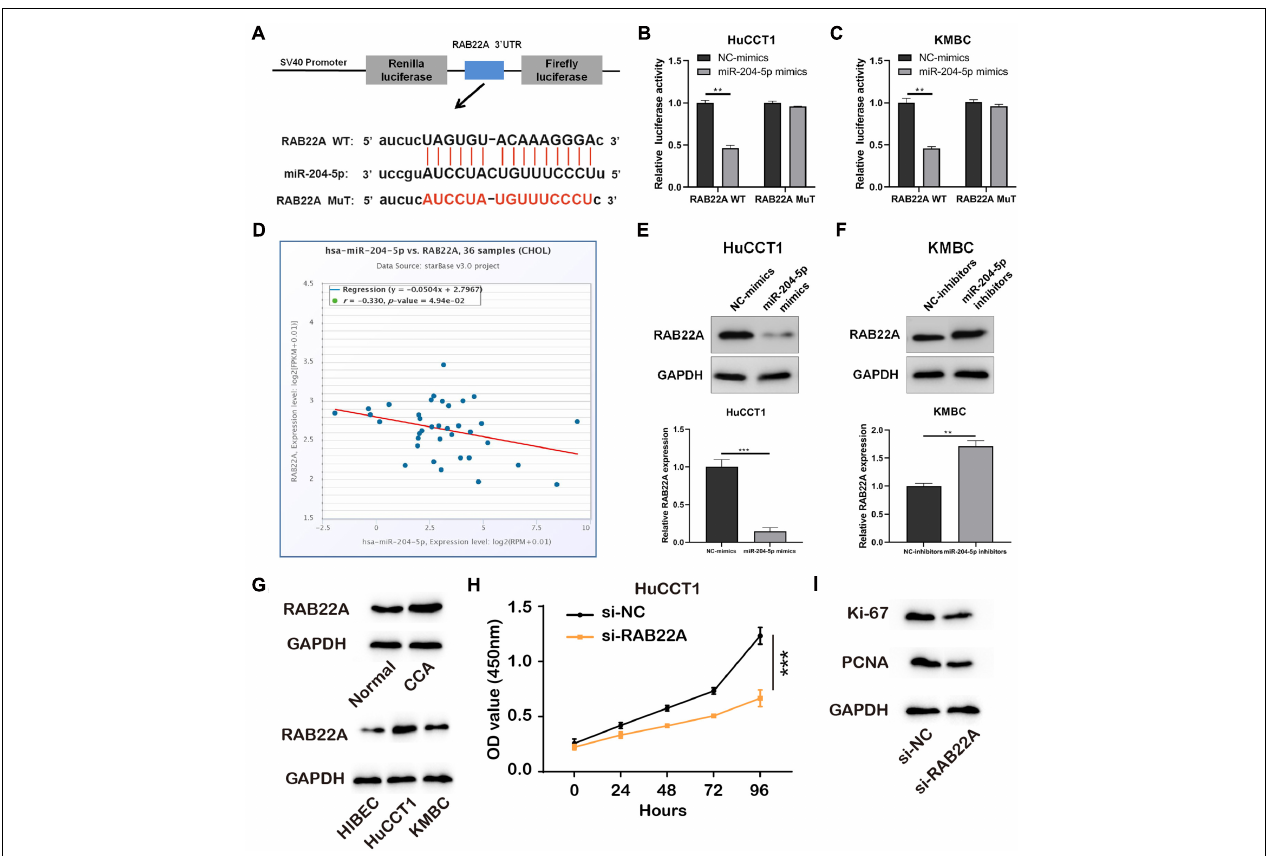
FIGURE 4 | RAB22A is a direct target of miR-204-5p. (A) Schematic illustration of RAB22A-WT and RAB22A-MuT luciferase reporter vectors and the binding sites between RAB22A and miR-204-5p. (B,C) The relative luciferase activities were detected in HuCCT1 and KMBC cells after co-transfection with RAB22A-WT/MuT and miR-204-5p mimics/NC-mimics, respectively. (D) The correlation between miR-204-5p and RAB22A in CCA tissues. (E,F) The western blot was used to detect the expression of RAB22A in HuCCT1 and KMBC cells transfected with miR-204-5p mimics and miR-204-5p inhibitors, respectively. (G) The levels of RAB22A in CCA and normal tissues and CCA cell lines were investigated using western blotting. (H) The proliferation of transfected CCA cells was determined by CCK-8 assay. (I) The levels of proliferation makers, Ki-67 and PCNA, were investigated using western blotting. All experiments were repeated at least three time. ** P < 0.01, *** P <